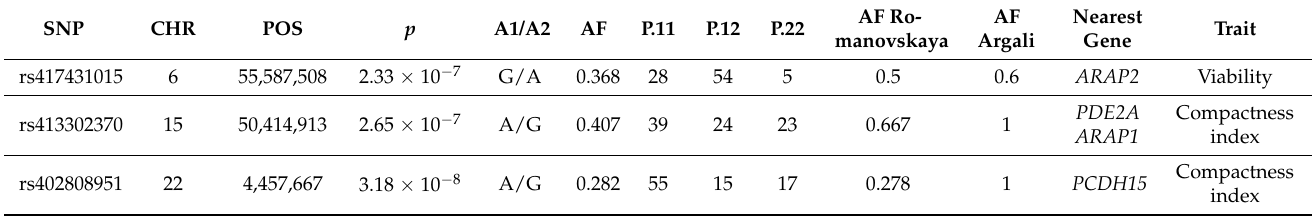
Table 2. Loci significantly associated with viability and compactness index.